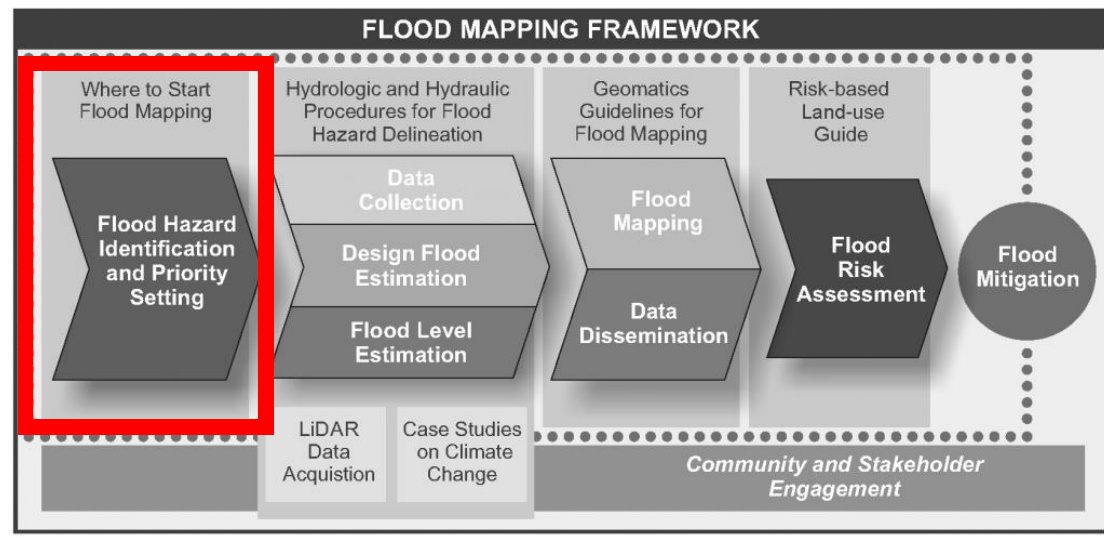
Figure 1. Federal flood mapping framework. Source: NRCan [4].